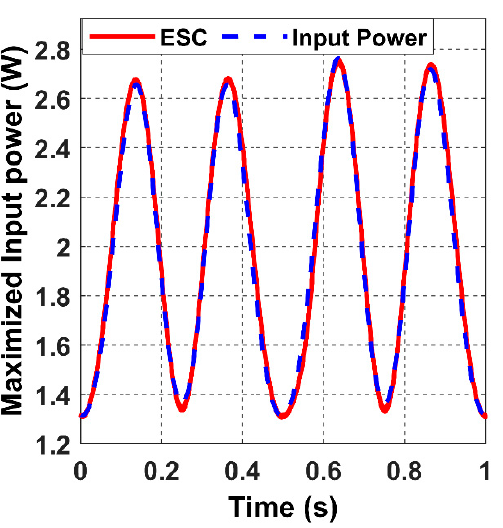
Figure 24. The system’s closed-loop output when the receiver moves in the 8-shaped trajectory 𝝘 .